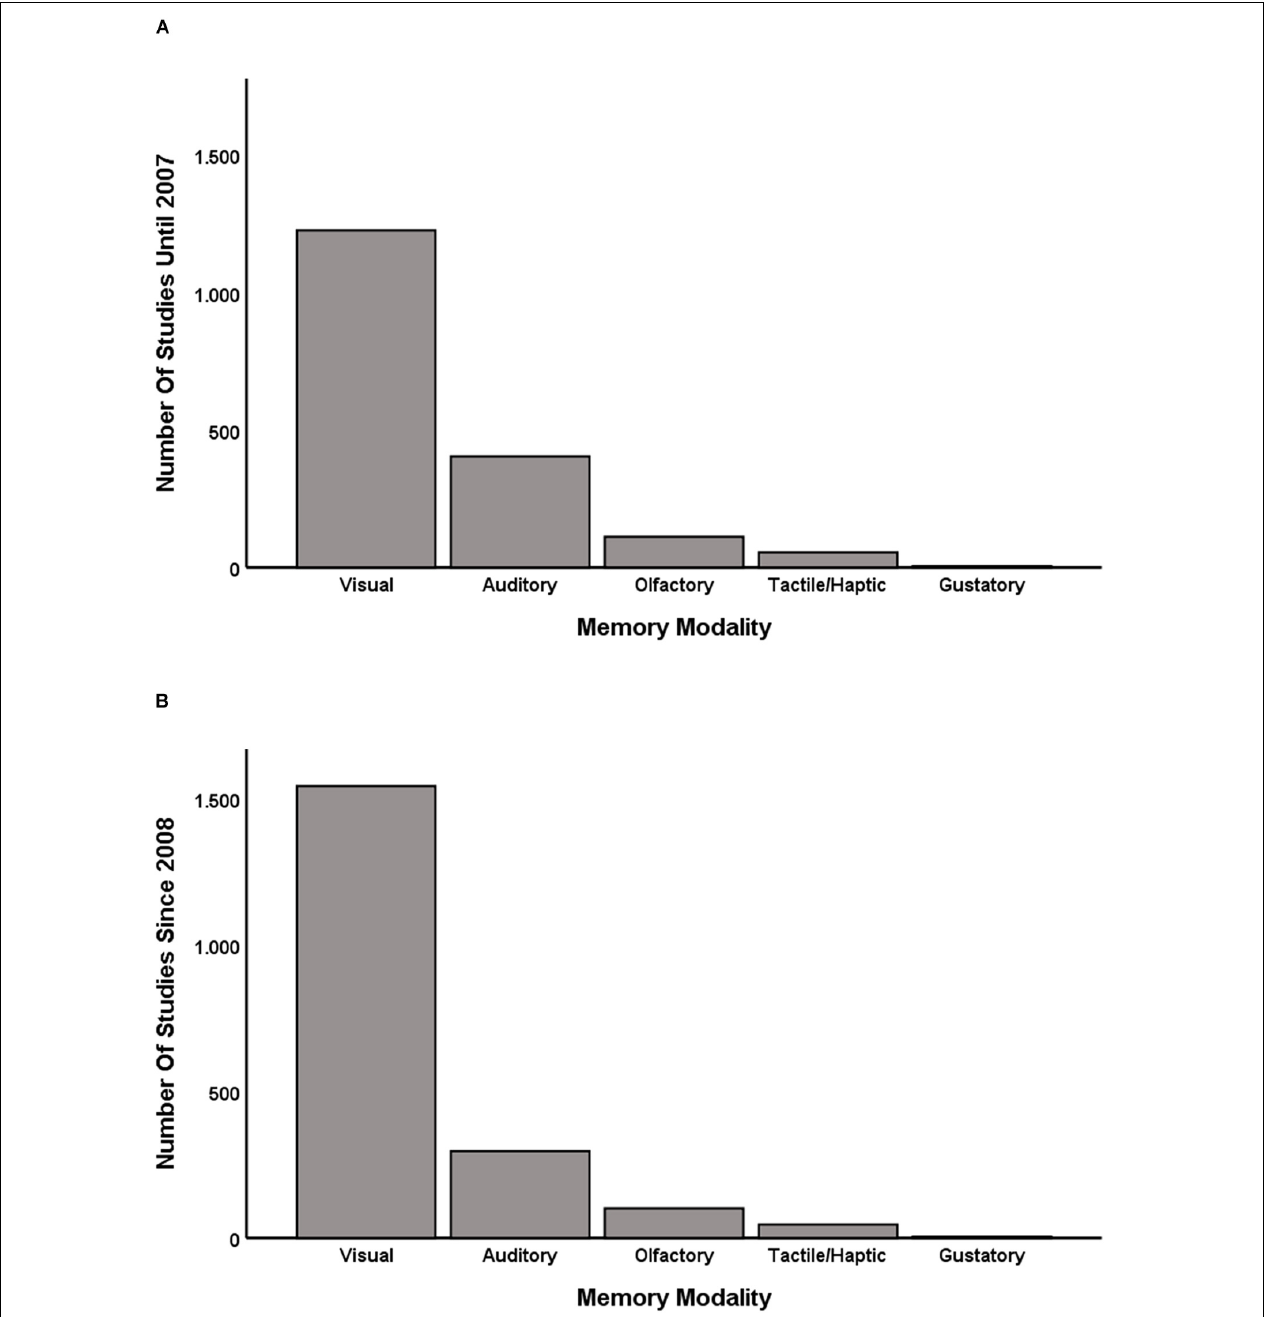
FIGURE 1 | The number of studies on the different sensory modalities published until the end of 2007 is depicted in panel (A) ; the number of studies on the different sensory modalities published since the beginning of 2008 is depicted in panel (B) . Following the procedure by Gallace and Spence (2009), I searched the PsycINFO database for studies containing “auditory,” “gustatory,” “olfactory,” and “tactile/haptic memory” in the title (search date: May 29, 2019) (see Supplementary Data Sheet 1